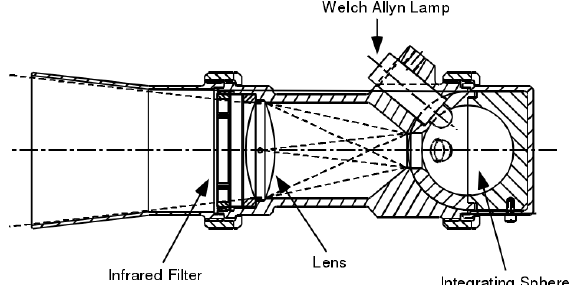
Figure 2. EO-1 ALI internal calibration source (J.A. Mendenhall,